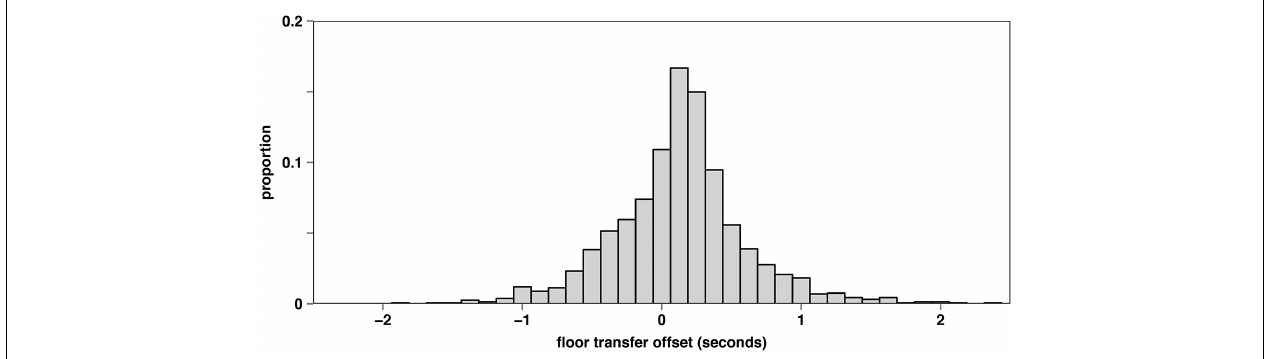
FIGURE 1 | FloorTransfer Offset (FTO) distribution of the German telephone